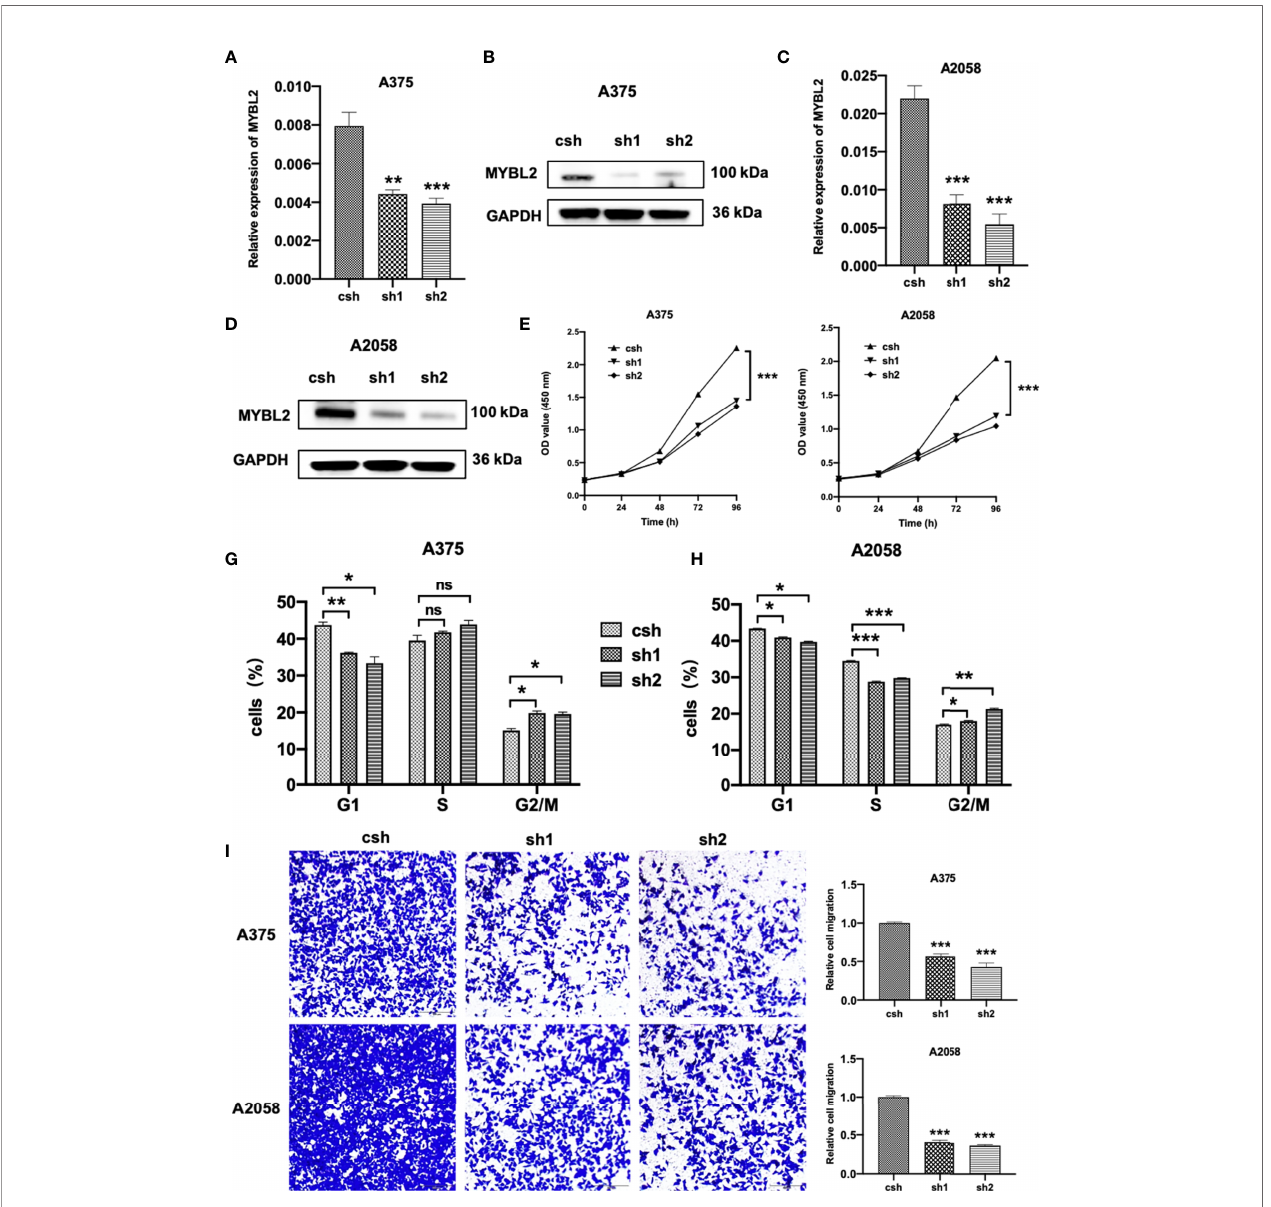
FIGURE 2 | MYBL2 is essential to cell survival in melanoma cells. (A – D) qPCR and Western blot analyses of MYBL2 in melanoma cell lines A375 and A2058 using pLL3.7 lentivirus-expressing control shRNA (csh) and 2 different MYBL2 shRNAs (sh1 and sh2). (E, F) Proliferation of cells with csh, sh1, and sh2 targeting MYBL2 at 0, 24, 48, and 96 h was detected. (G, H) Flow cytometric analysis was performed to assess cell cycle phase status after staining with propidium iodide (PI). (I) Images and quantitative cell migration of melanoma cells after transfection with MYBL2 -shRNAs lentiviruses. These experiments were repeated at least 3 times. * p < 0.05, ** p < 0.01, *** p < 0.001. ns P > 0.05, no signi fi cant